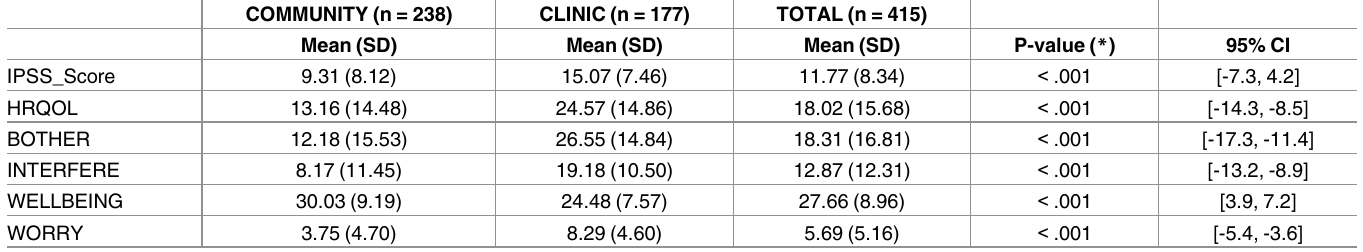
Table 3. Comparison of sites by scale scores.